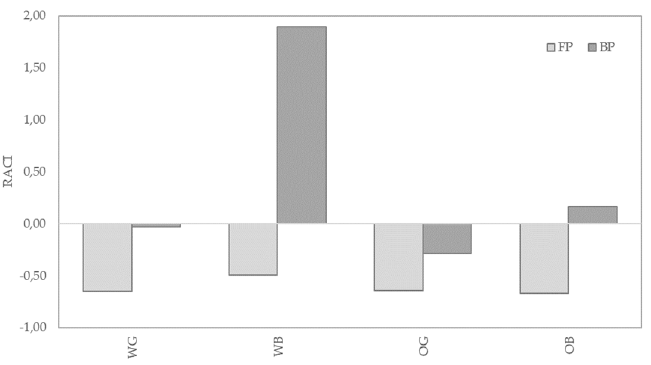
Figure 5. RACI values for free phenolic fraction (FP) and insoluble phenolic fraction (BP) of wheat grain (WG), oat grain (OG), and their bran, wheat bran (WB) and oat bran (OB).